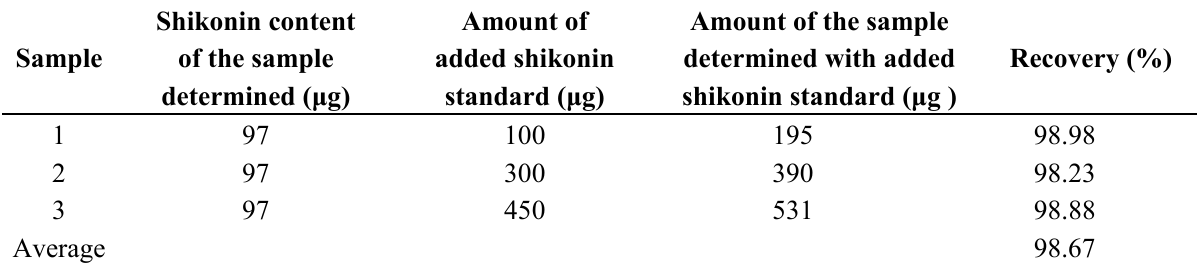
Table 4. The recovery of shikonin from radix A. euchroma (n = 3).